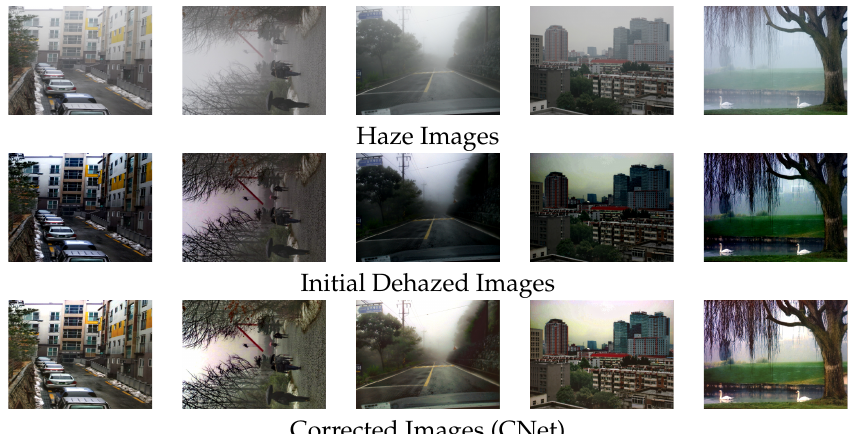
Figure 3. Performance of the proposed CNet. The proposed CNet can adaptively correct the intensity and contrast via HNet features and adaptive normalization. The HNet uses this corrected data as ground truth for complementary